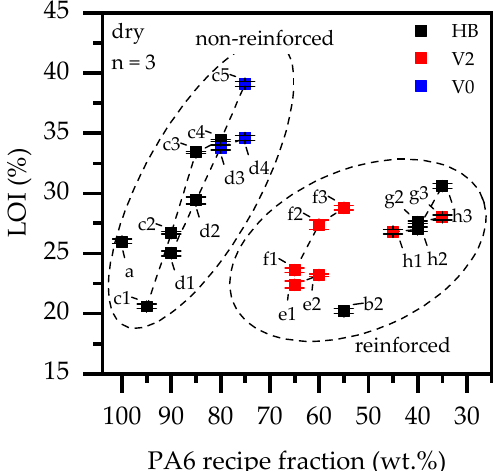
Figure 8. UL-94 and LOI test results for 2 mm thick samples. Table 3. Summary of UL-94 and LOI testing results.